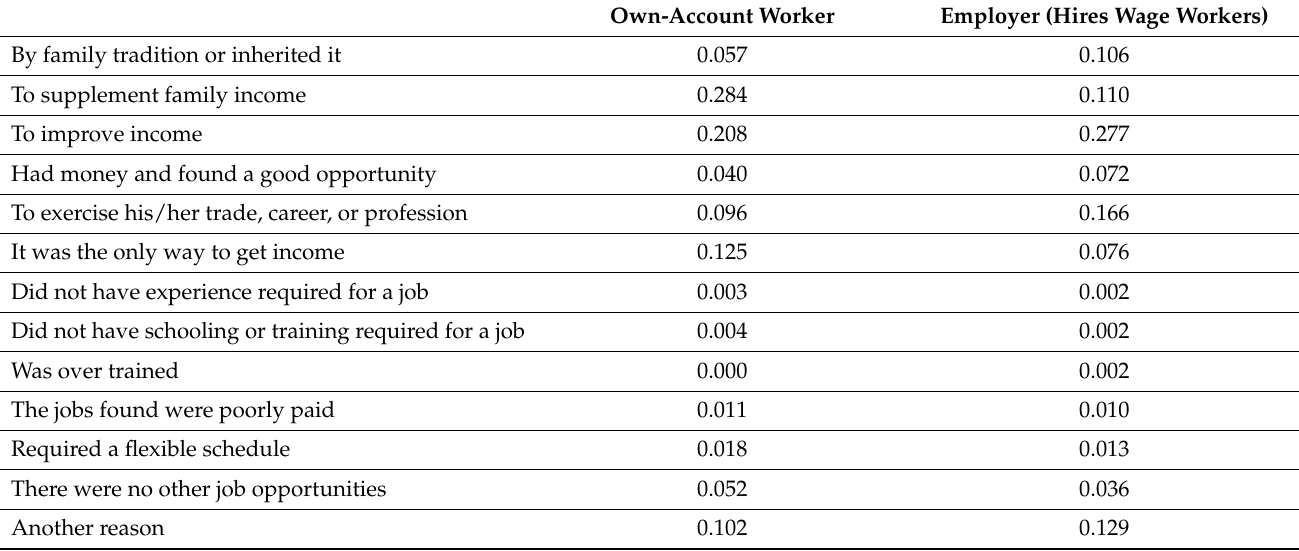
Table 7. Reason to start a micro-unit in